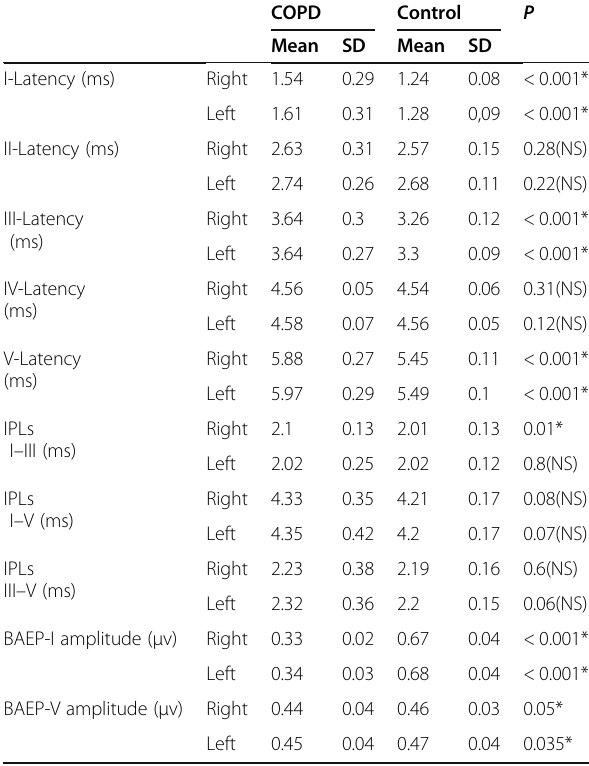
Table 2 Comparison between patient and control groups as regards the auditory brain stem evoked potential (ABR) COPD Control